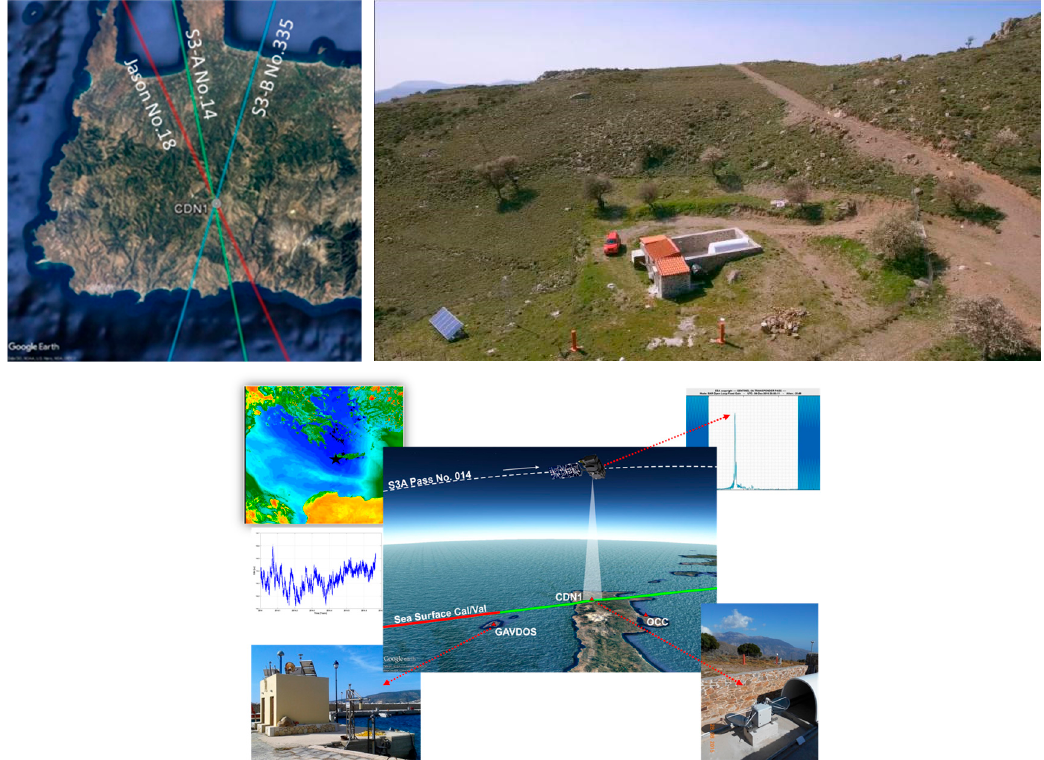
Figure 2. Upper Left: The CDN1 transponder Cal/Val site has been established to support Cal/Val activities for the Sentinel-3A (green) and Sentinel-3B (blue) missions and for the Jason (red) series (future Sentinel-6/Jason-CS). Upper Right : Aerial view of the CDN1 transponder Cal/Val site in West Crete Mountains. Lower : The sequential calibration of Sentinel-3 along the ascending Pass No.14 with sea-surface and transponder techniques, respectively. Overview of the calibration process along with photos from the satellite calibration infrastructure.